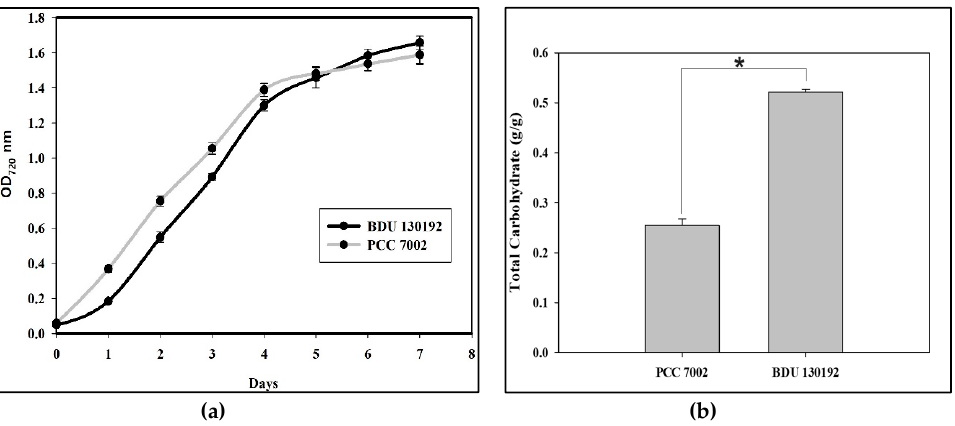
Figure 1. Comparison of two Synechococcus strains, BDU 130192 and PCC 7002 with air bubbling: ( a ) growth pattern; ( b ) Total carbohydrate measured when OD 720 reached to 1. Data presented as mean ± s.d. of three independent replicates. (* shows p < 0.005 value).